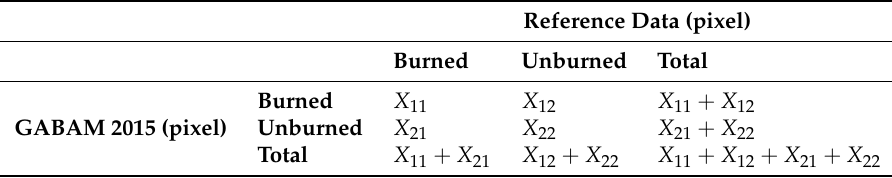
Table 6. Cross-tabulation between Global annual Burned Area Map (GABAM) 2015 and the reference data. Reference Data (pixel) Burned